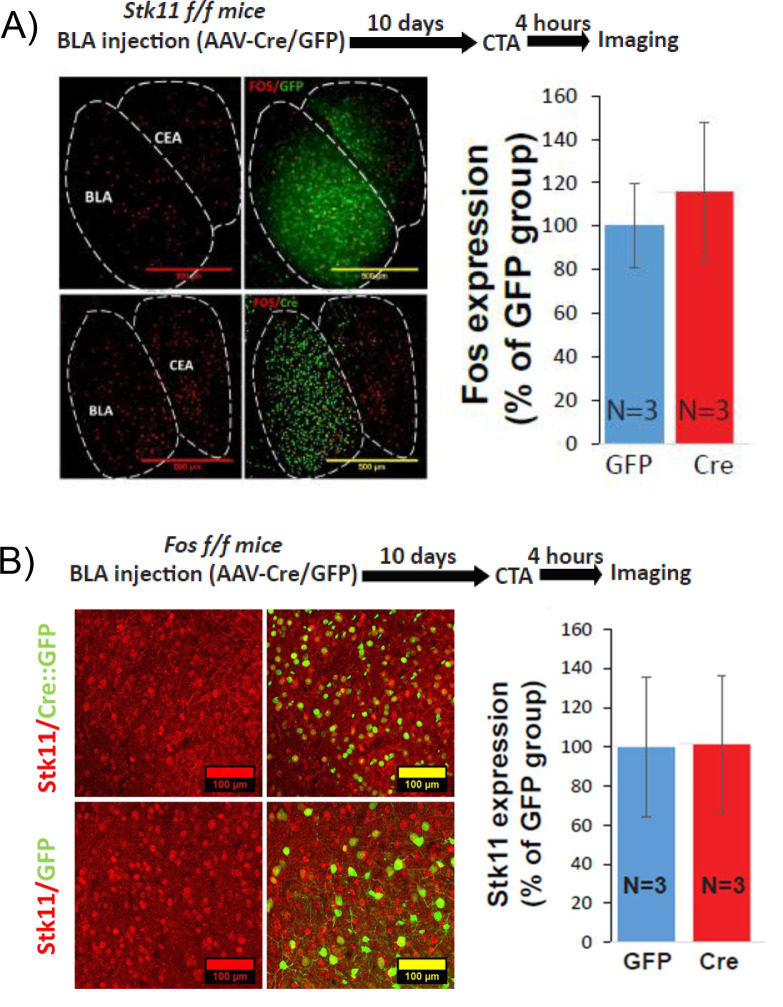
The expression of Stk11 or Fos is not dependent upon the expression of the other.(A) Stk11 deletion in BLApn does not change C-FOS expression. C-FOS protein expression in the BLA was measured 4 hr following CTA training in Stk11f/f mice receiving Cre or control virus injection 10 days earlier. There was no difference between the groups (t(4)=-0.4; p=0.69, N = 3/group). (B) Fos deletion in BLApn does not change STK11 expression. STK11 protein expression in the BLA was measured 4 hr following CTA training in Fosf/f receiving Cre or control virus injection 10 days earlier. There was no difference between the groups (t(4)=0.03; p=0.84, N = 3/group). See also Figure 5—figure supplement 1—source data 1–2.Figure 5—figure supplement 1—source data 1.Stk11 deletion in BLApn does not change C-FOS expression.This data relates to Figure 5—figure supplement 1 panel A.Figure 5—figure supplement 1—source data 2.Fos deletion in BLApn does not change C-FOS expression.This data relates to Figure 5—figure supplement 1 panel B.